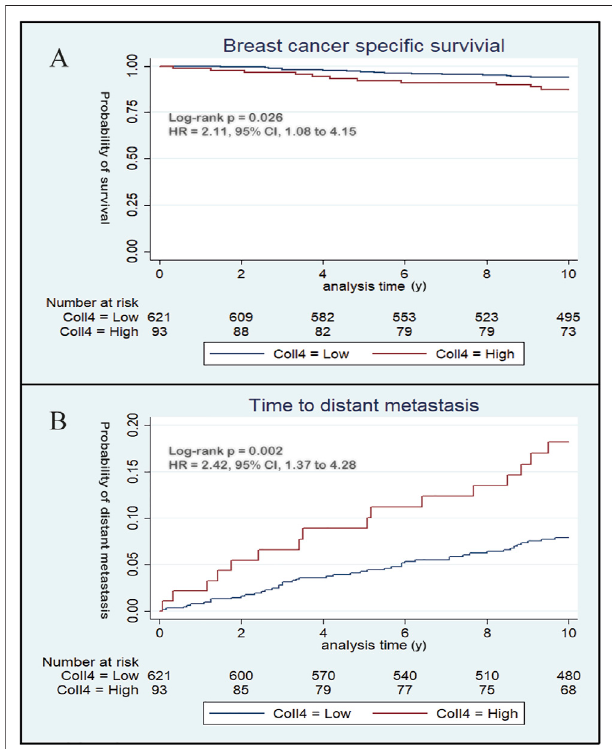
FIGURE 4 | Kaplan-Meier curves demonstrate the prognostic potential oftypeIVcollagen. (A) Duringthe fi rst10 yearsoffollowup,highexpressionof type IV collagen was associated with a poorer breast cancer speci fi c survival compared to low expression of type IV collagen and (B) high expression of type IV collagen was positively associated with distant